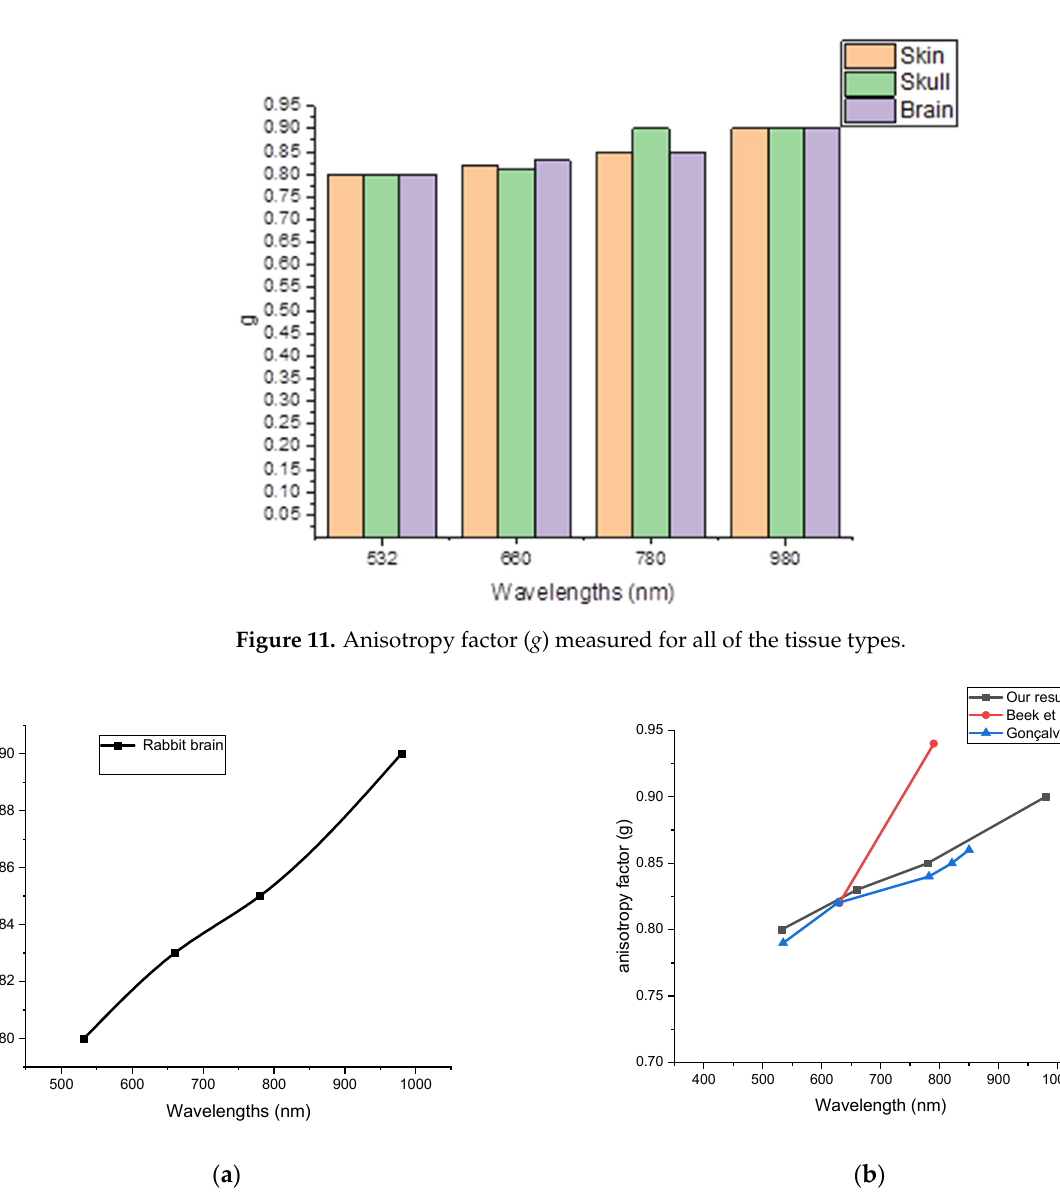
Figure 10. Variation in the calculated optical parameters at different wavelengths for all three investigated types of rabbit head tissues: absorption coefficient ( a ), reduced scattering coefficient ( b ), and penetration depth of the rabbit brain using Equation (10) ( c ). In our implementation, we measured the anisotropy factor ( g ) of all of the tissue types. These data are presented in Figure 11.